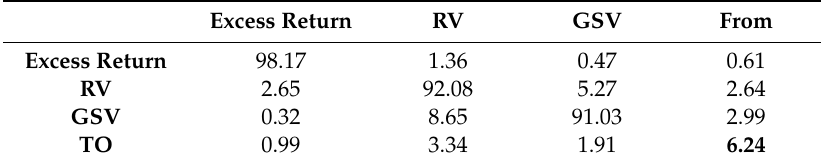
Table 9. Total spillover, Czech